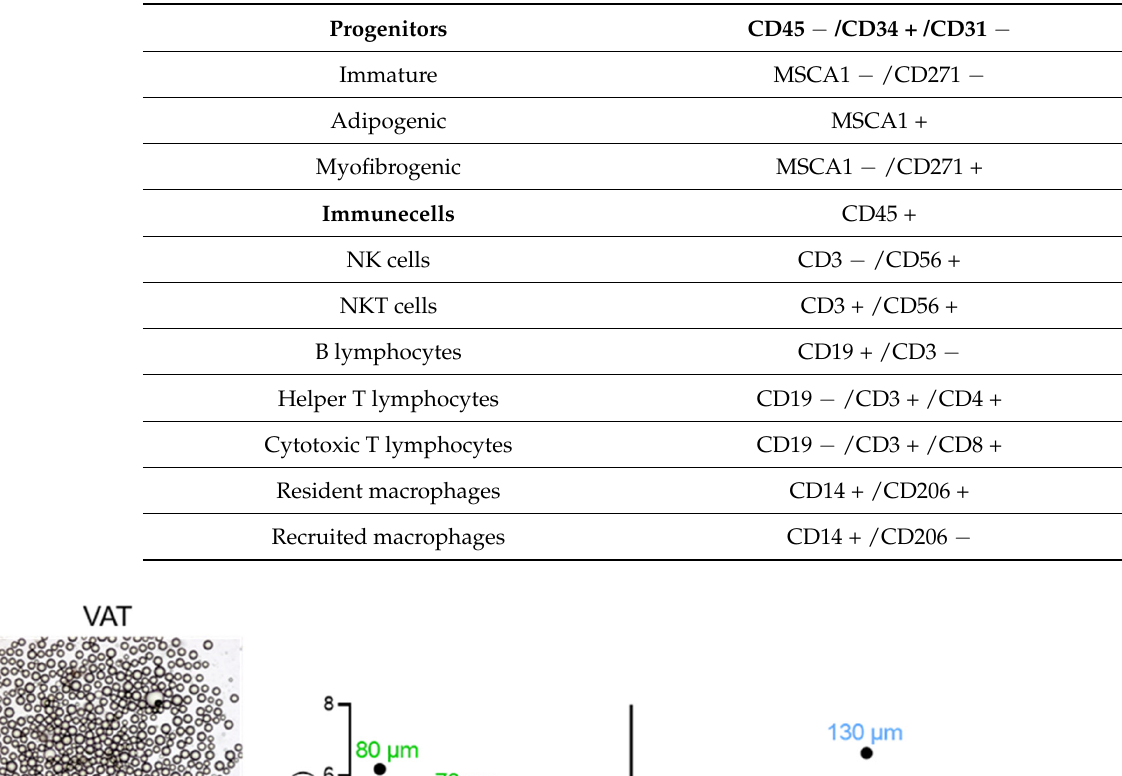
Table 2. Cell surface markers of AT stromal cell subtypes.